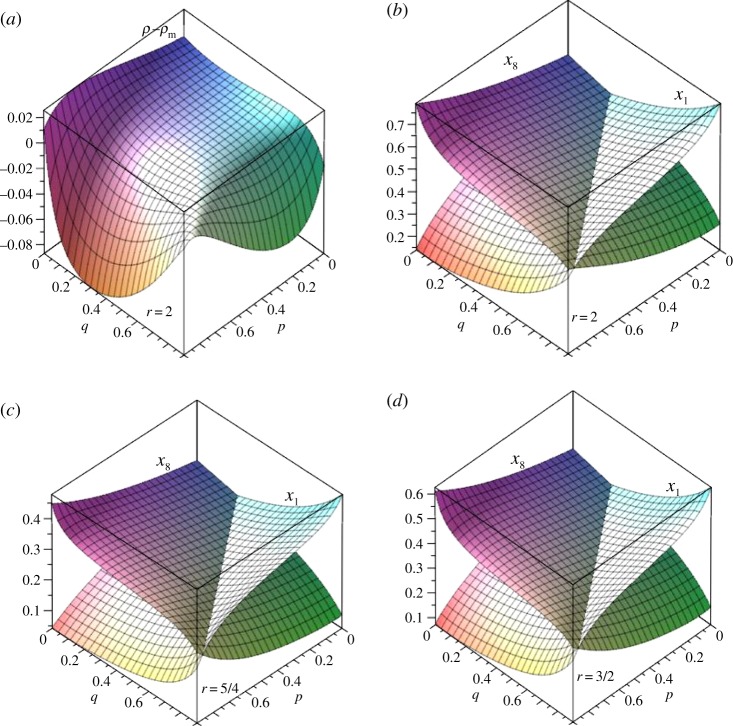
Single vertex fixation probabilities for (3,4) partial bipartite graph with r=5/4, 3/2 and 2. (a) Fixation probability minus Moran probability with r=2, (b–d) fixation probabilities starting on three sides (sheet that is lower at q=0) compared to that starting on fourth side for r=5/4, 3/2, 2.